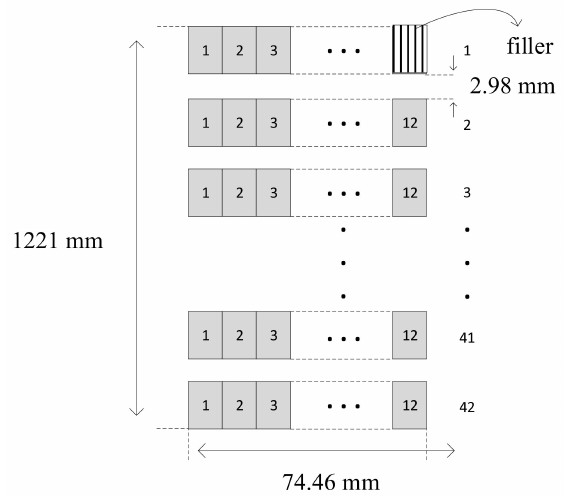
Figure 6. The arrangement of disk for HV